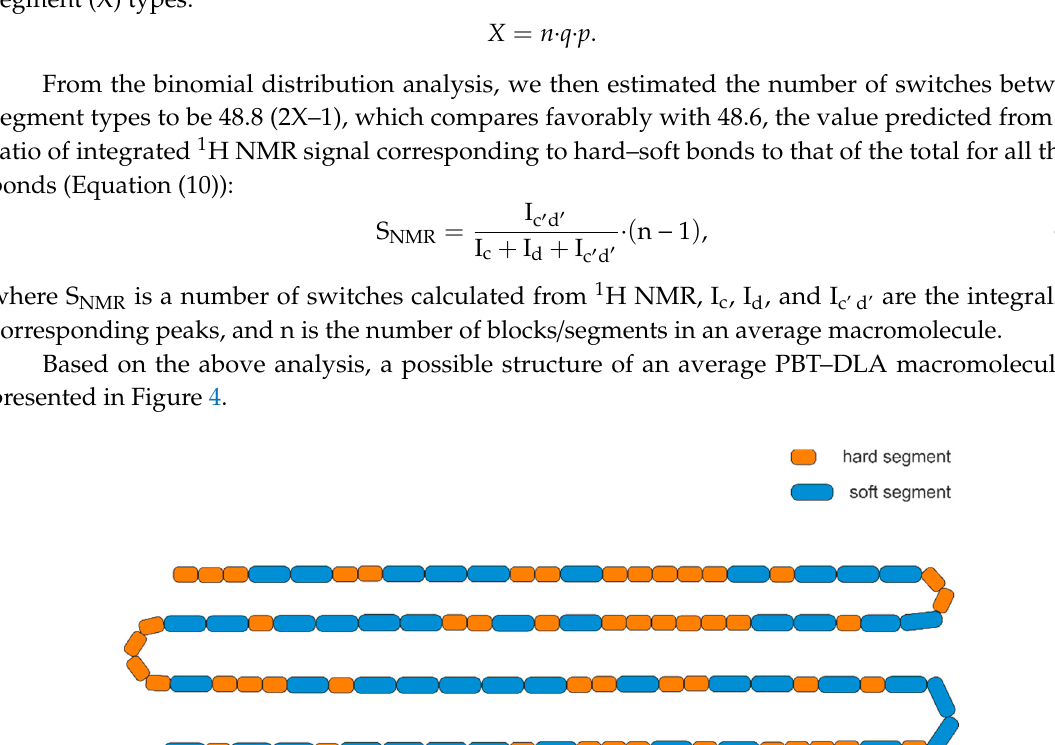
Table 3. Segment length distributions. Segment length,